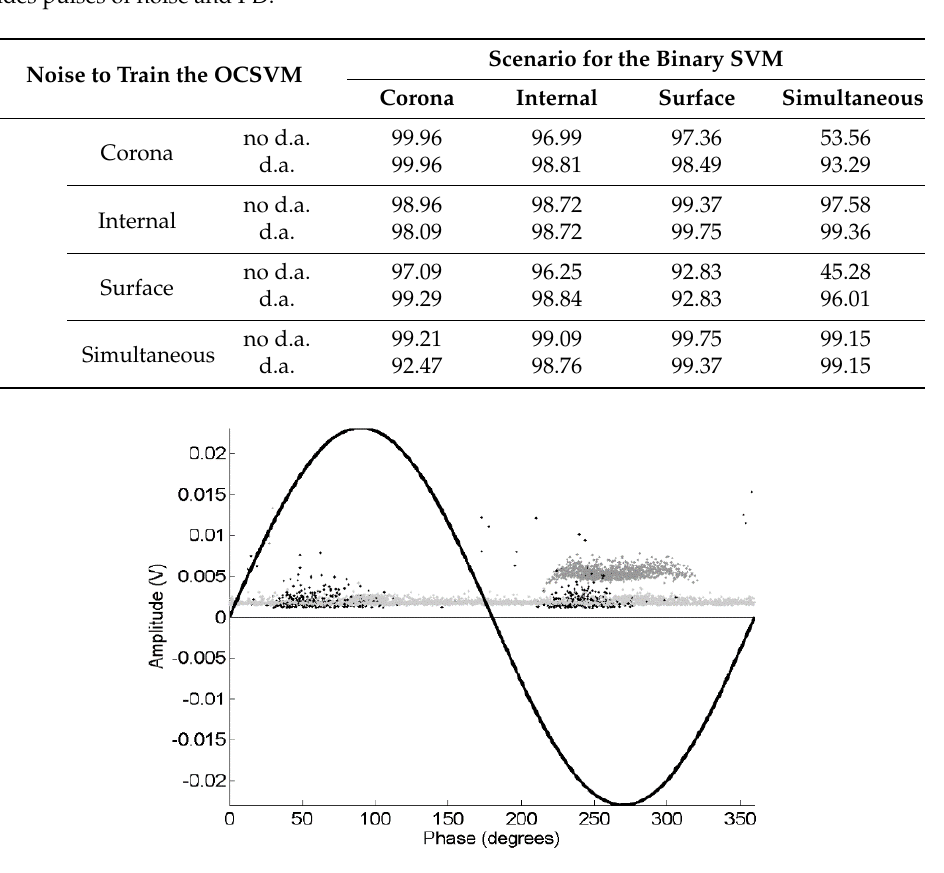
Figure 8. PRPD for predicted pulses with binary SVM (from [20]).